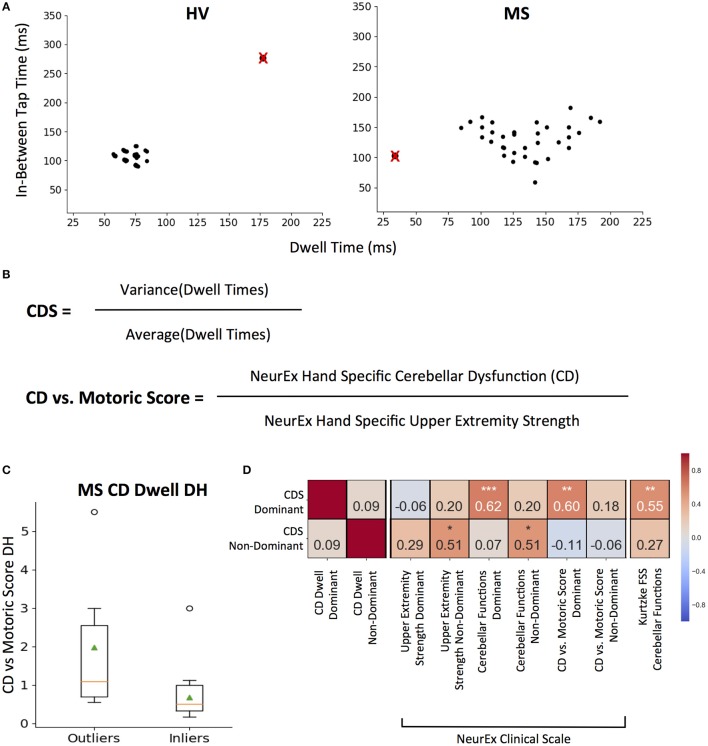
CDS: Cerebellar Dysfunction Score designed to better separate cerebellar from motoric disability. (A) Representative tapping patterns for Healthy Volunteer (HV) participant and Multiple Sclerosis (MS) participants. Individual plot is of a 10 s tap trial, with the corresponding dwell time and in-between tap time for each tap. The black points with a red “x” represents example outlier taps for dwell time and/or in-between tap time that is eliminated based on IQR thresholds as defined in the methods. (B) Generating cerebellar dysfunction score (CDS) based on dwell times to quantify tapping regularity. The score for each tapping trial is the coefficient of variation of inlier dwell times. Generating Cerebellar Dysfunction (CD) vs. Motoric dysfunction clinical score by comparing NeurEx scores for hand specific cerebellar dysfunction with upper extremity strength. (C) Distribution of Cerebellar vs. Motoric scores between MS groups that were outliers and inliers for the CDS. On each box plot, green triangles indicate the mean and orange lines indicate the median of depicted cohort datasets. Box plot box boundaries represent the Q1 to Q3 range centered about the median. Box plot whisker lengths extend to Q1–1.5 *IQR and Q3 + 1.5 *IQR. (D) Pearson correlations between CDS for dominant and non-dominant hands and corresponding clinical scores. Red to blue heat map represents value of the correlation coefficient ranging from 1 to −1, respectively. *p < 0.01, **p < 0.001, ***p < 0.0001.